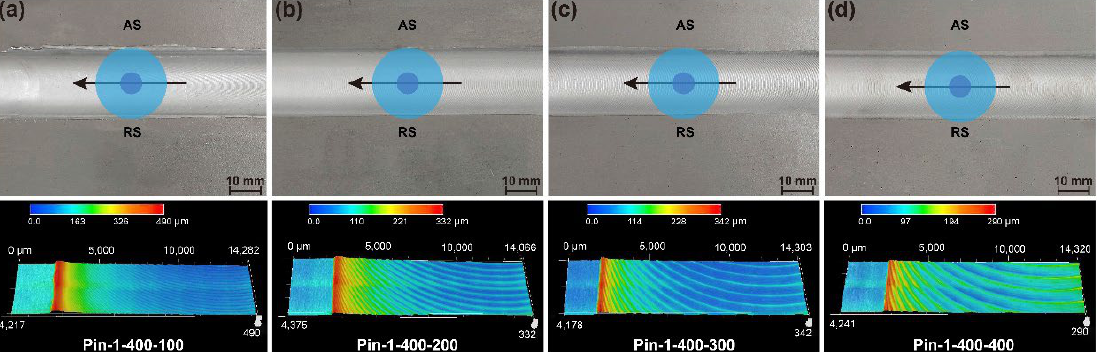
Figure 3. Surface morphologies ( a ) Pin-1-400-100, ( b ) Pin-1-400-200, ( c ) Pin-1-400-300, and ( d ) Pin-1-400-400.